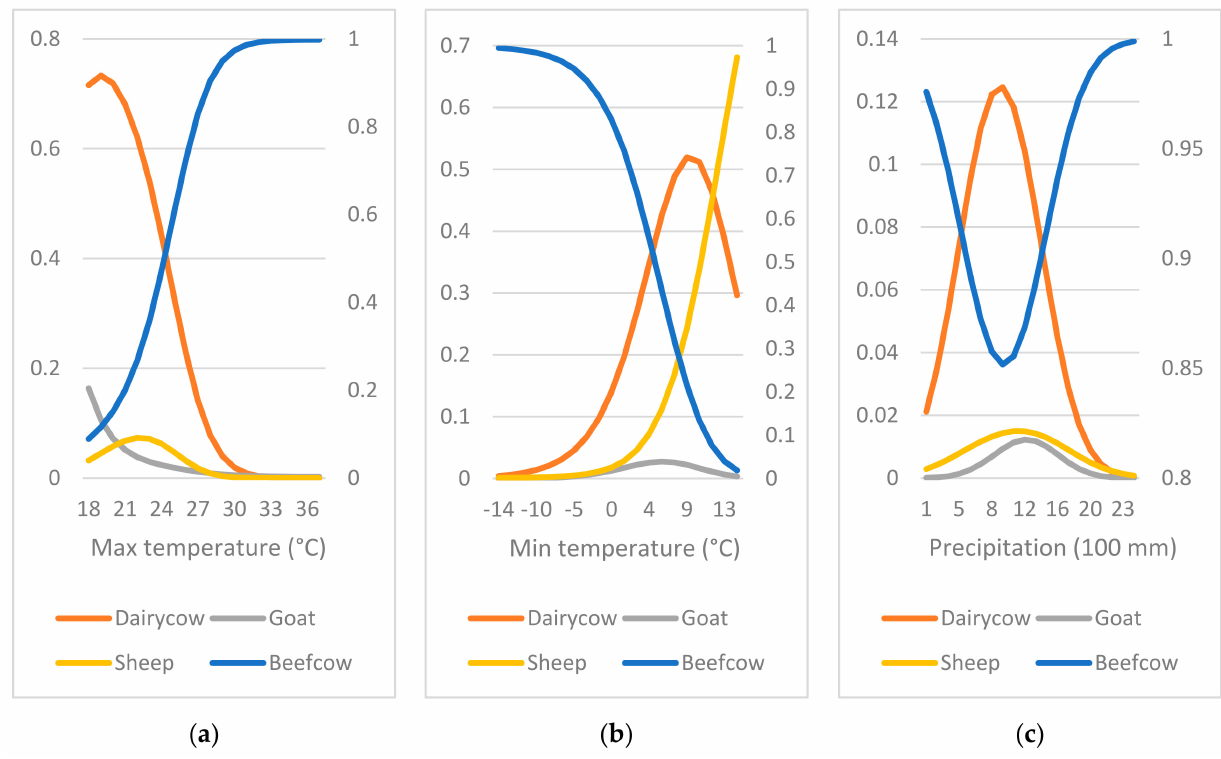
Figure 2. Average marginal effect of climate variables on land shares in the east: ( a ) Maximum Temperature; ( b ) Minimum Temperature; ( c )